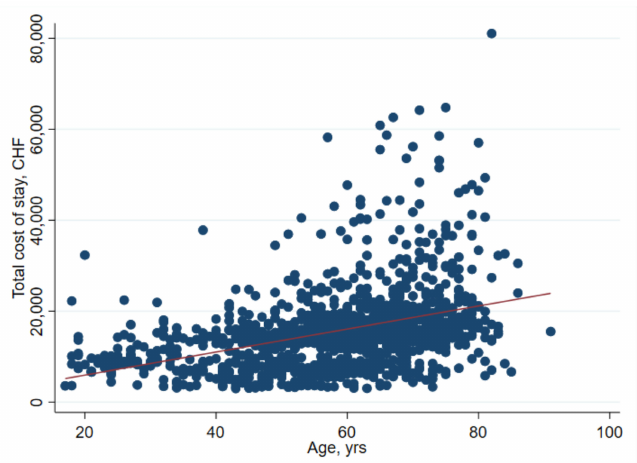
Figure 2. Correlation between age and total cost of stay-total cost of stay increased proportionally with